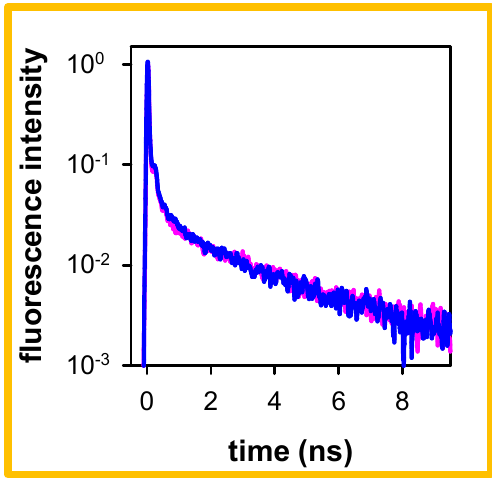
Figure 3. Normalized fluorescence decays recorded at 305 nm for pA • pT in the standard buffer (blue) and in KCl solution with the same ionic strength (pink); excitation wavelength: 267 nm. The time-resolved spectra and the decays presented so far (Figures 2 and 3) were obtained following excitation at 267 nm. As reported in reference [29], the steady-state fluorescence spectra remain the same when the excitation wavelength varies between 245 and 285 nm. Here, we found that when the excitation wavelength shifted from 267 nm to 285 nm, the 305 nm decay obtained for pA • pT becomes somewhat faster (Figure 4a). Small changes also appear for the 420 nm decay, representative of the low-energy fluorescence (Figure 4b). However, the percentage of photons emitted on the ns timescale remains more important at 305 nm compared to 330 nm (Table 1), close to the maximum of the steady state fluorescence spectrum (Figure 1).